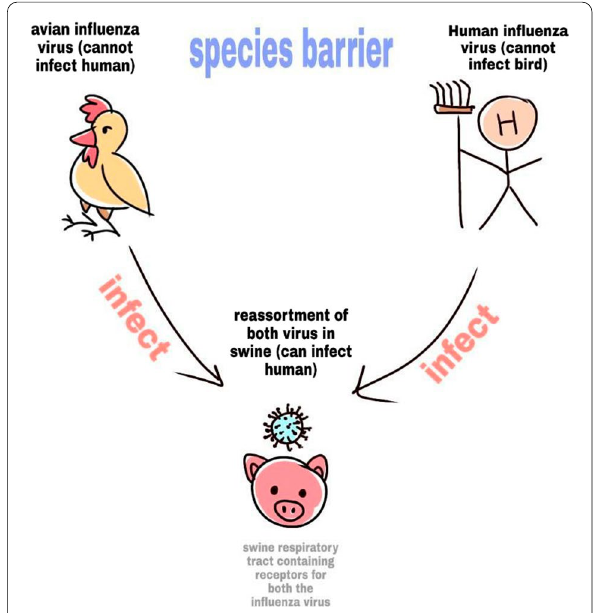
Fig. 2 Re-assortment of different influenza viral strains in intermediate